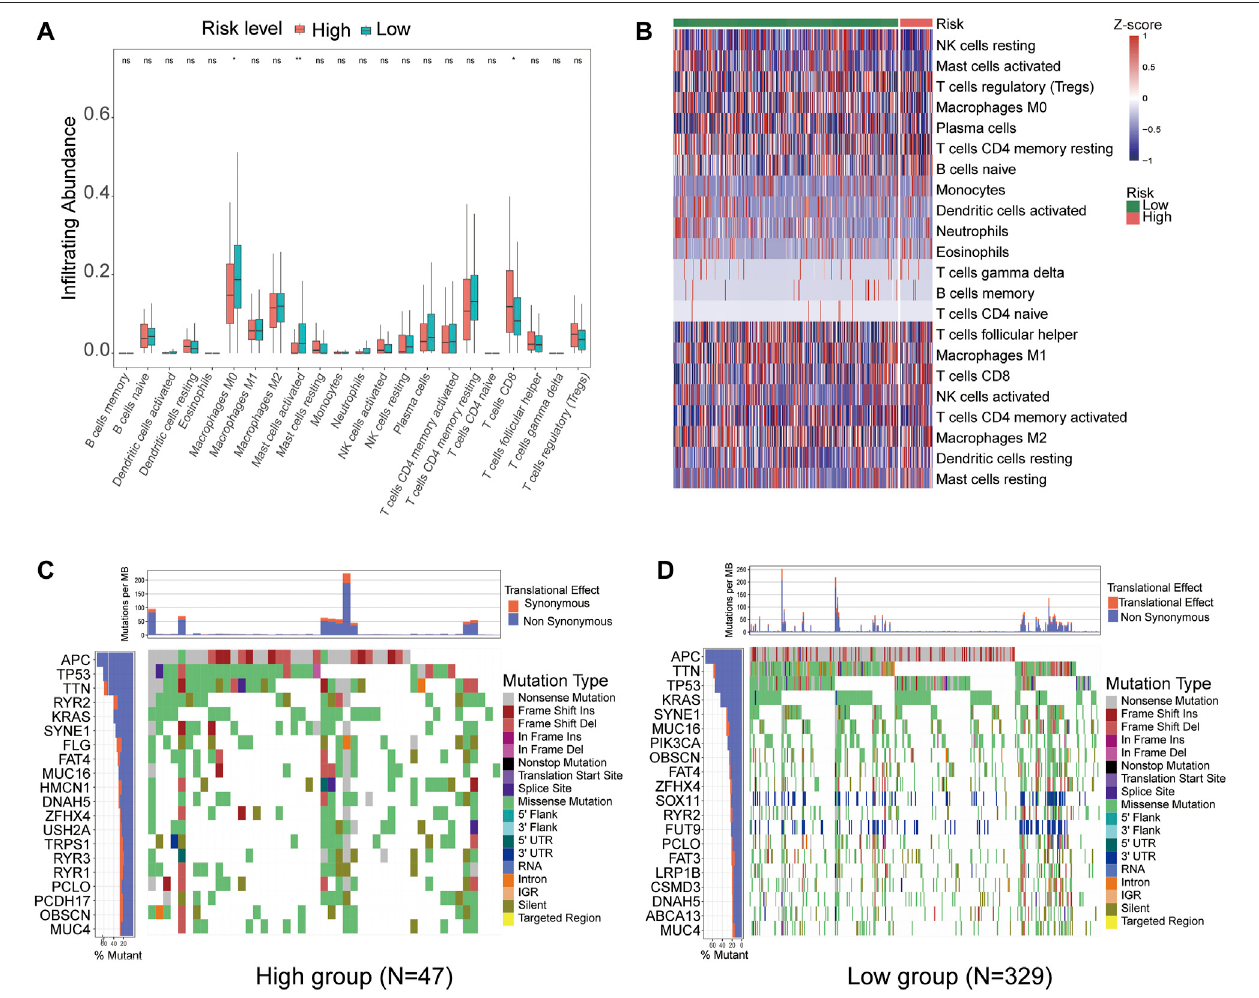
FIGURE 7 | CIBERSORT identi fi ed the relative in fi ltration of 22 immune cell type subpopulations with different risk groups in the TCGA cohort. (A) The boxplot shows 22 immune cell types in different risk groups. (B) The relative in fi ltration of each cell type was normalized to the Z score. (C,D) The waterfall plot of tumor somatic mutations established by those with high-risk scores (C) and low-risk scores (D)